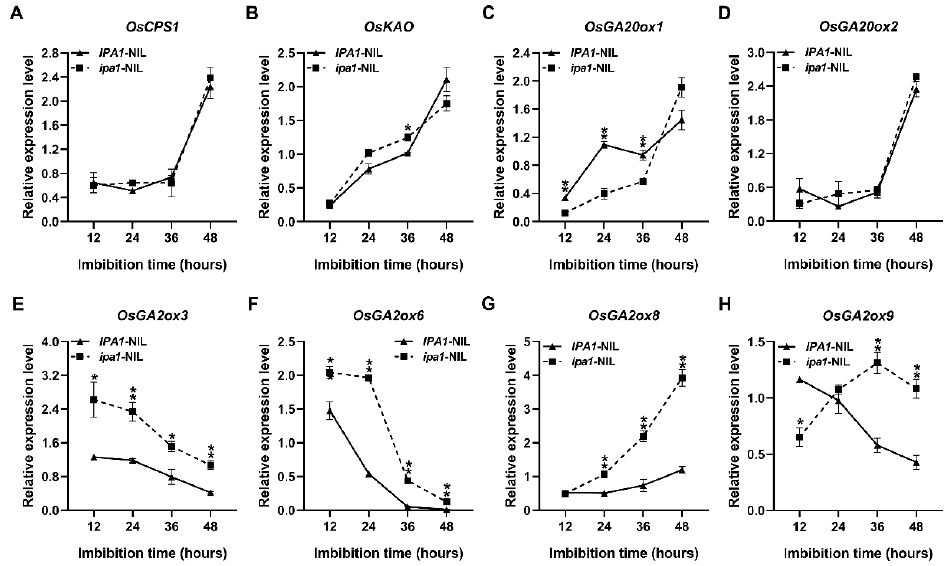
Figure 4. The transcript levels of genes related to GA biosynthesis and inactivation at different time points. ( A – D ) The relative expression level of GA biosynthesis-related gene OsCPS1 ( A ), OsKAO ( B ), OsGA20ox1 ( C ), and OsGA20ox2 ( D ). ( E – H ) The relative expression level of GA metabolism-related gene OsGA2ox3 ( E ), OsGA2ox6 ( F ), OsGA2ox8 ( G ), and OsGA2ox9 ( H ). Values are means ± SE ( n = 3). Significant differences were determined using Student’s t -test (* p < 0.05, ** p < 0.01).